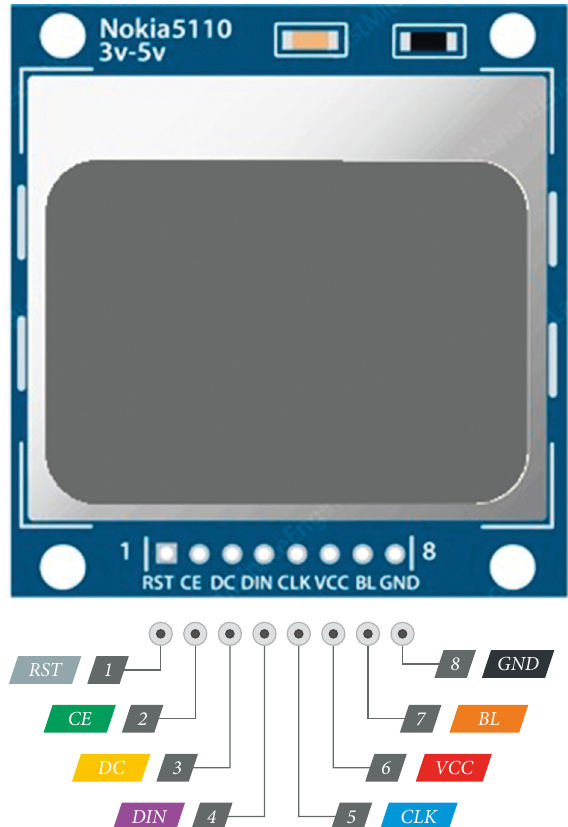
Figure 7: The Nokia 5110 LCD pinout (as adopted from https://